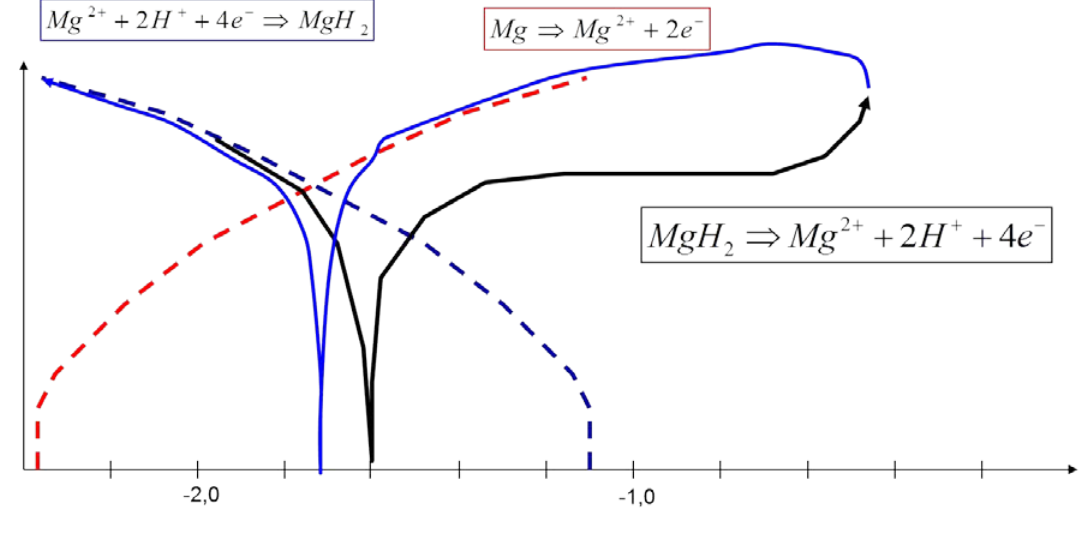
Figure 7. The scheme to describe the mixed potential effect on Mg or Mg alloy surfaces for an interpretation of the shape of I vs. E curves using a slow scan rate of 10 mV/s. Dashed lines = the anodic part of Mg oxidation (red) and the cathodic part of the hydrogen evolution (blue); Full line = the forward scan (black) and the backward scan